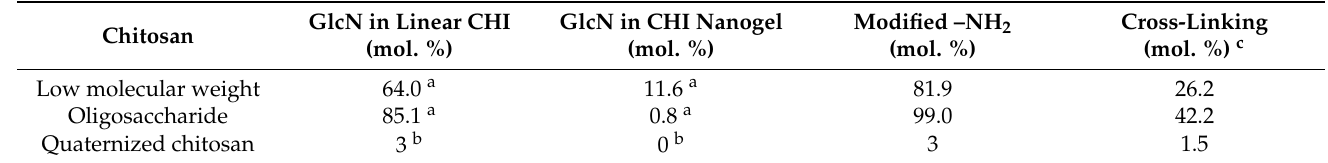
Table 1. Cross-linking degree of nanogels synthesized from different chitosans and chitosan derivatives estimated as half of the functionalization grade, measured by the Hb and Ha 1 H NMR relative intensities.